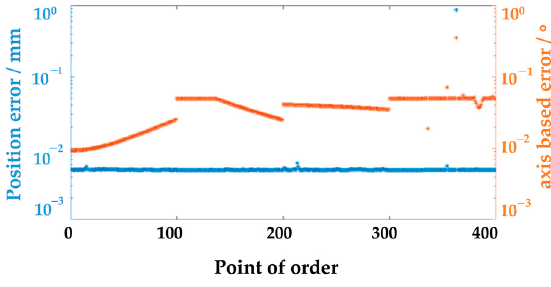
Figure 9. The inverse solution via the SQP algorithm.